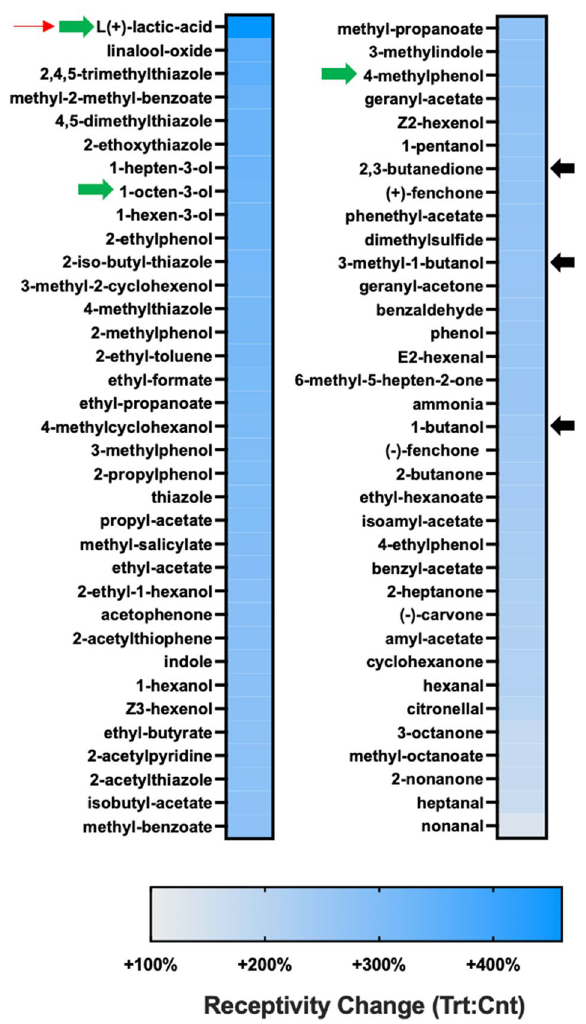
Figure 6. Calculated changes in Anopheles gambiae odorant receptor (AgOR) mediated odorant receptivity following relevant sporozoite infections. Graphic representation of conceptualized differences in odorant receptivity for 70 odors in Plasmodium falciparum sporozoite infected treatments (Trt) vs. naïve controls (Cnt). Response characteristics were determined using known An. gambiae odorant receptor responses in heterologous expression systems and weighted by relative AgOR expression levels for each corresponding receptor. Results are sorted high to low. Scale bar show calculated increases